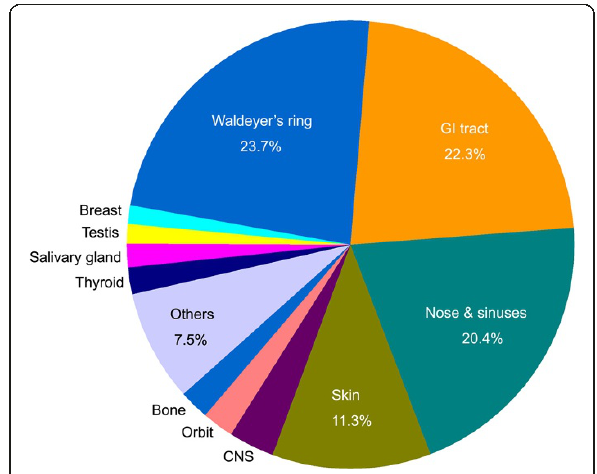
Figure 3 Extranodal sites involved in non-Hodgkin lymphoma . Waldeyer ’ s ring includes tonsil, palate, nasopharynx, pharynx and base of tongue; GI tract (gastrointestinal tract) includes stomach, small intestine and colon; Nose & sinuses includes nasal cavity and paranasal sinuses; CNS, central nervous